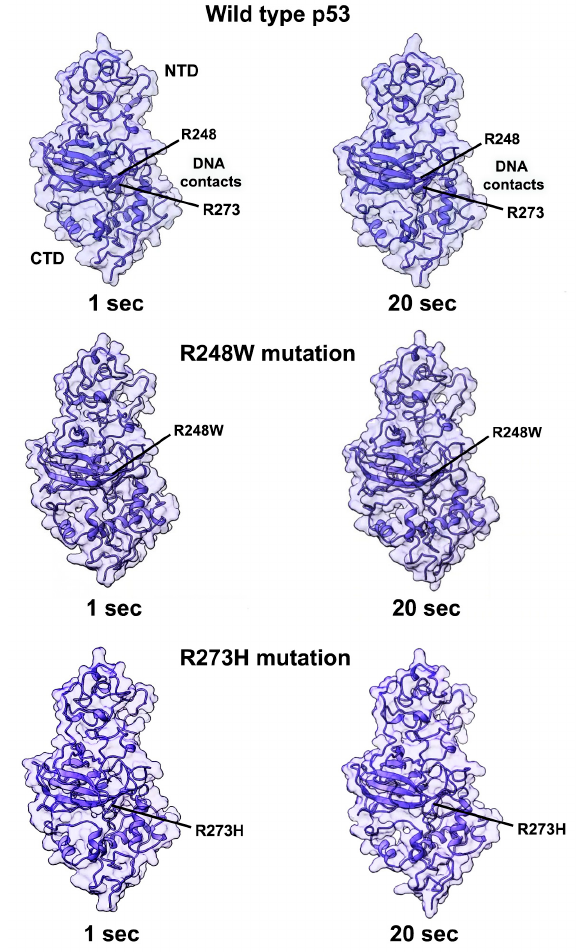
Figure 5. Simulations to demonstrate subtle allosteric changes in WT p53 in comparison to models of mutated p53. Dynamic simulations were performed on WT p53 along with mutated models (R248W and R273H). Movie output yielded ~20 s recordings that were accelerated 4–fold to better visualize conformational changes (Movies S9–S11). Modest changes were noted throughout each structure with less movement in the lower have of the protein (DBD and CTD), which contains more secondary structure elements. The NTD regions of each model contain more loop elements and displayed visually more motion in video recordings. Labels point to mutations in the ribbon structure.